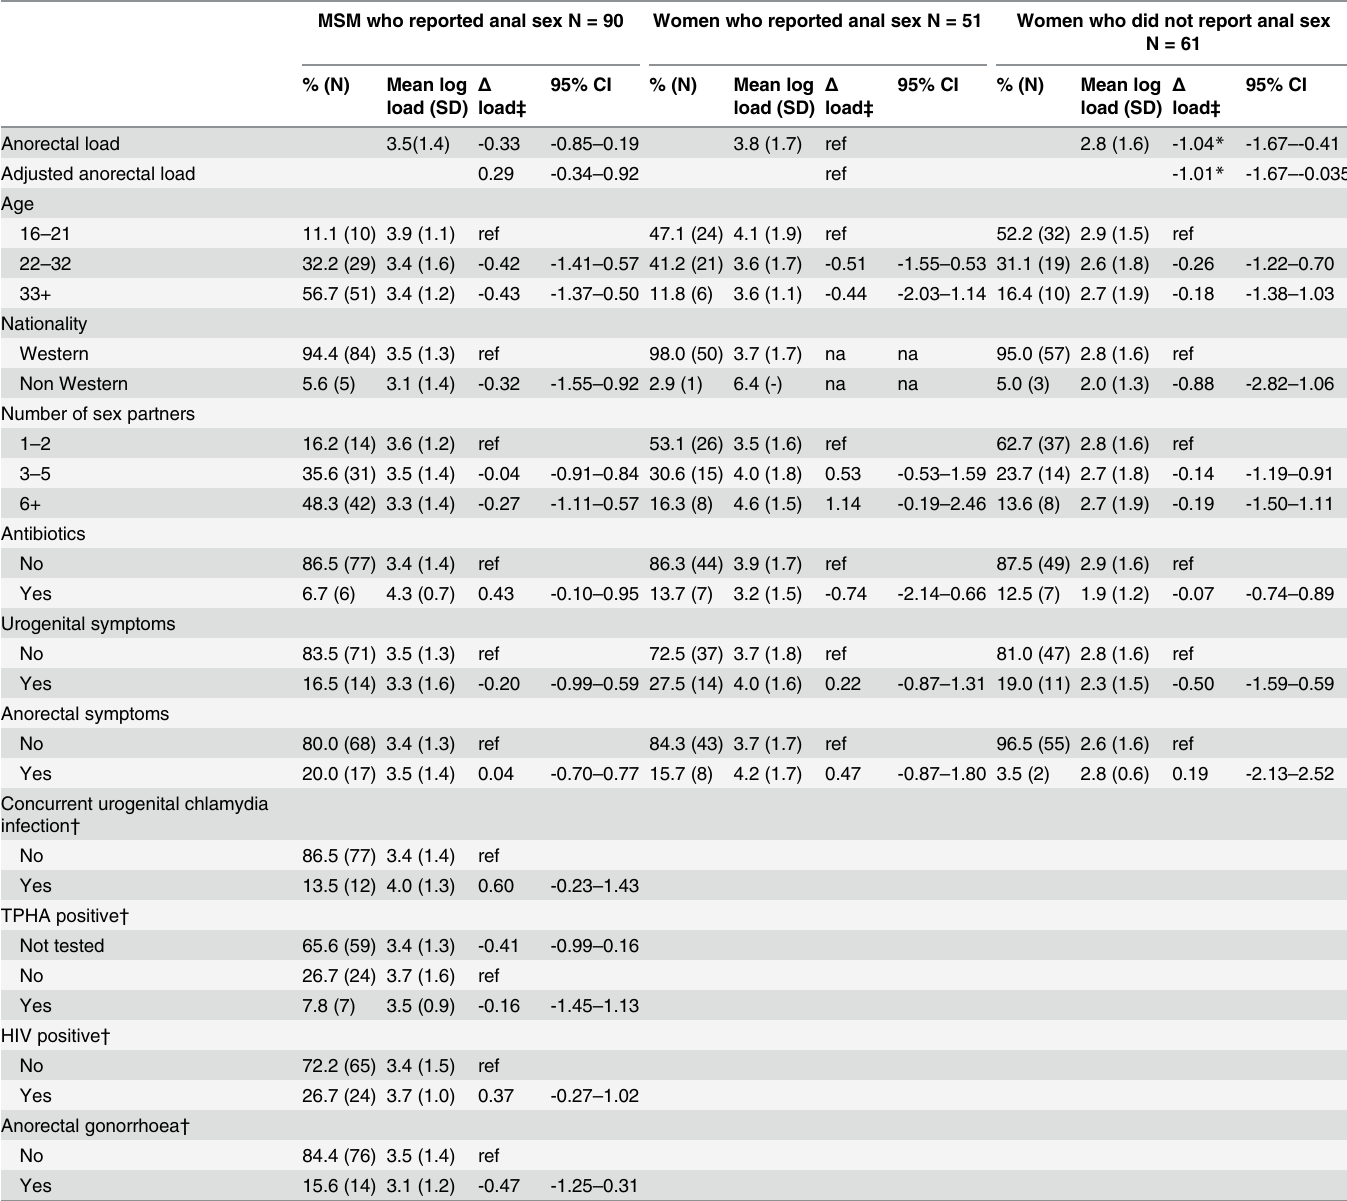
Table 1. Mean log-transformed number of chlamydia copies per millilitre (Ct/ml) (anorectal load) and associated determinants in MSM, women who reported anal sex and women who did not report anal sex by univariate linear regression